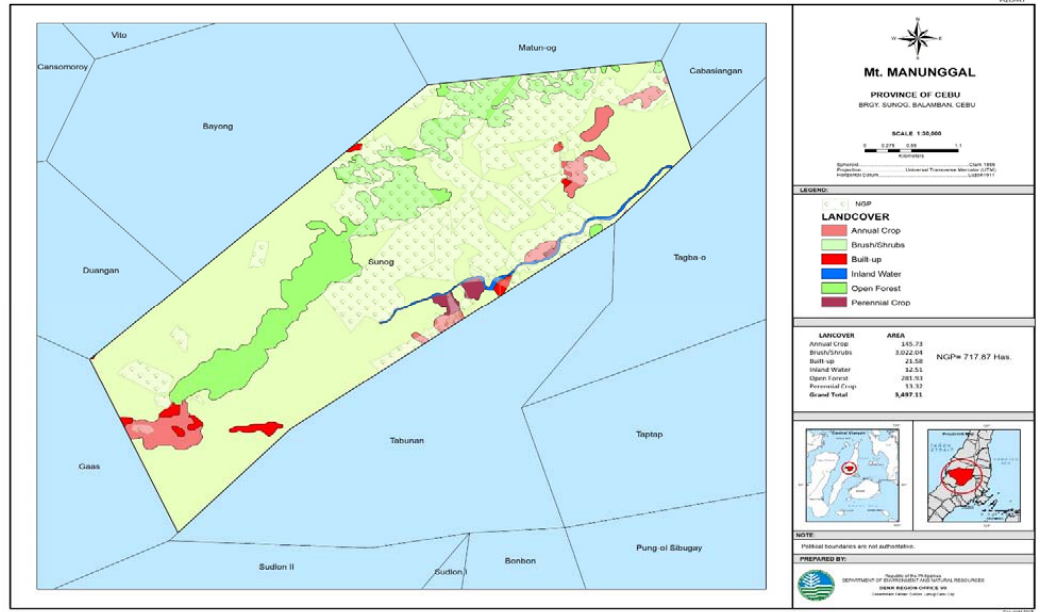
Fig. 1. Geographic location of the study area of Mt. Manunggal, Cebu Island, Philippines (DENR, 2017)